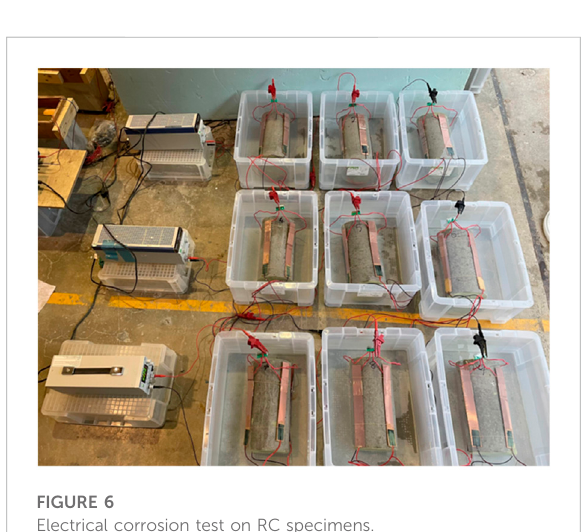
FIGURE 6 Electrical corrosion test on RC